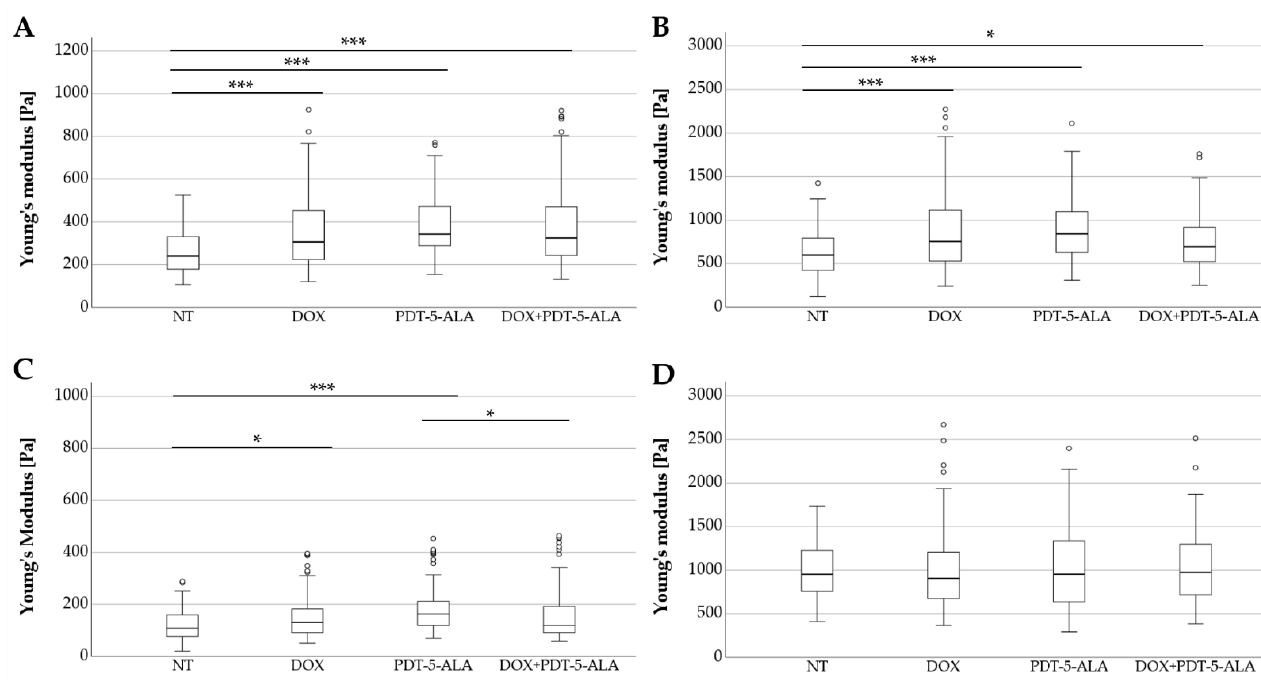
Figure 5. Analysis of Young’s modulus of human ES cell lines and MSC controls. Box plots (medians, minimum, maximum) of the cellular stiffness (Pa) for each cell line is displayed (RD-ES: ( A ) A-673: ( B ) TC-71: ( C ) MSC: ( D ). Outliners are depicted by circles. Statistical significance is indicated by stars over the compared datasets (* p < 0.05, *** p < 0.001). ES cells treated with DOX, PDT, or in combination were stiffer than their corresponding untreated cells, whereas MSCs serving as controls showed no significant change in elasticity. Abbreviations: 5-ALA — 5-aminolaevulinic acid; DOX — doxorubicin; ES — Ewing sarcoma; MSC — mesenchymal stem cell; NT — no treatment control; PDT — photodynamic therapy.